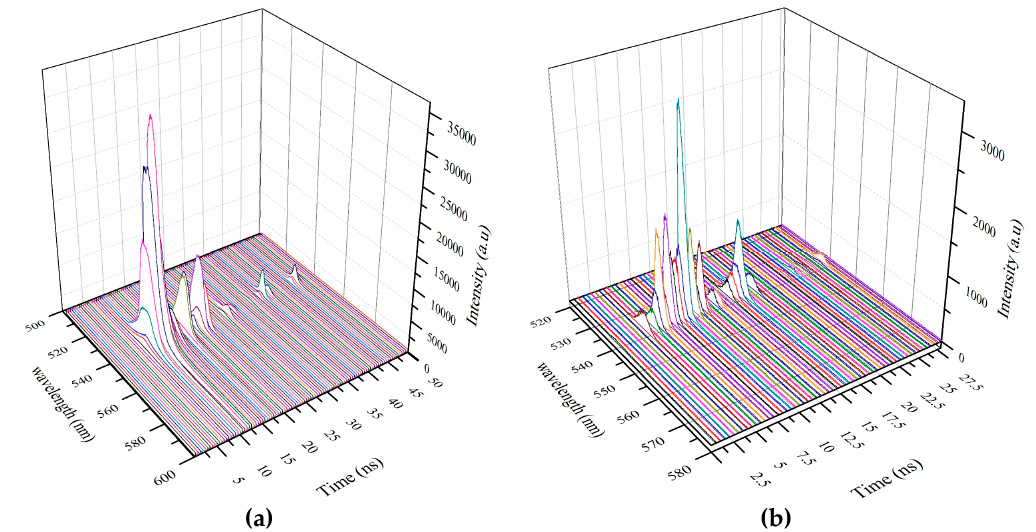
Figure 8. ( a ) Show the three dimensional (3D) ASE profile of GP under transverse excitation. It is displayed with wavelength (nm) in x -axis, Intensity (a.u) in y -axis and Time in z -axis, each fame represents a time duration of 0.5 ns. Note: ASE starts at z = 6 ns and reaches a maximum at 8 ns; but rapidly falls in next 500 ps. ( b ) Show the 3D representation of non-reproducible spikes of relaxation oscillation.